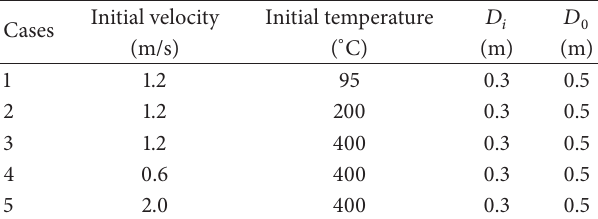
Table 1: Initial parameters of annular buoyant jets.